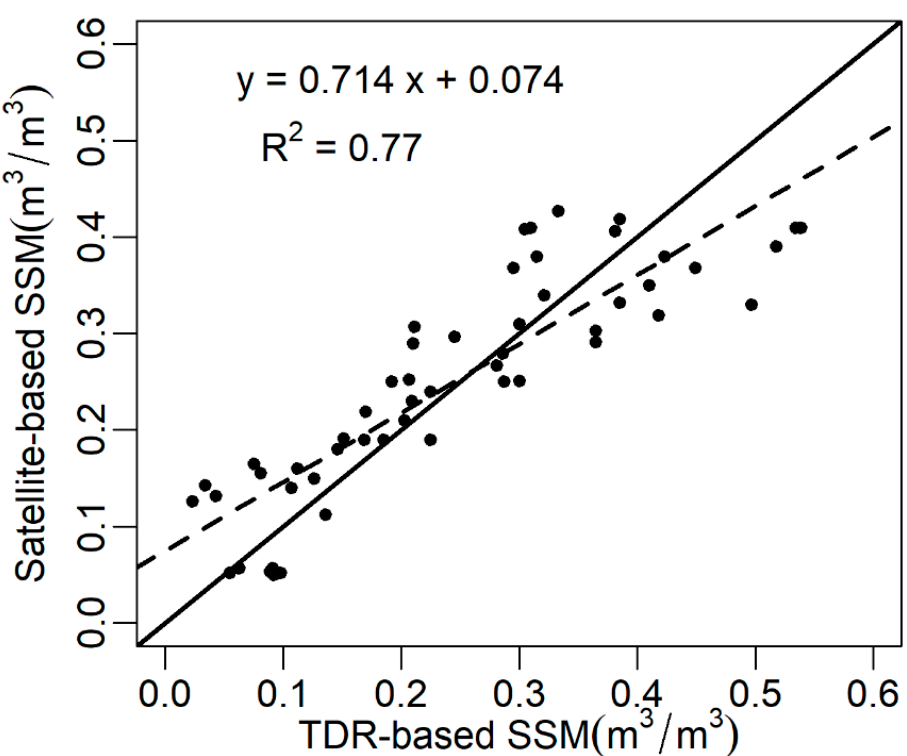
Figure 5. The 1:1 scatter plot showing the relationship between in-situ SSM and satellite-derived moisture ( n = 54). The dotted dash line represents the least square regression line.